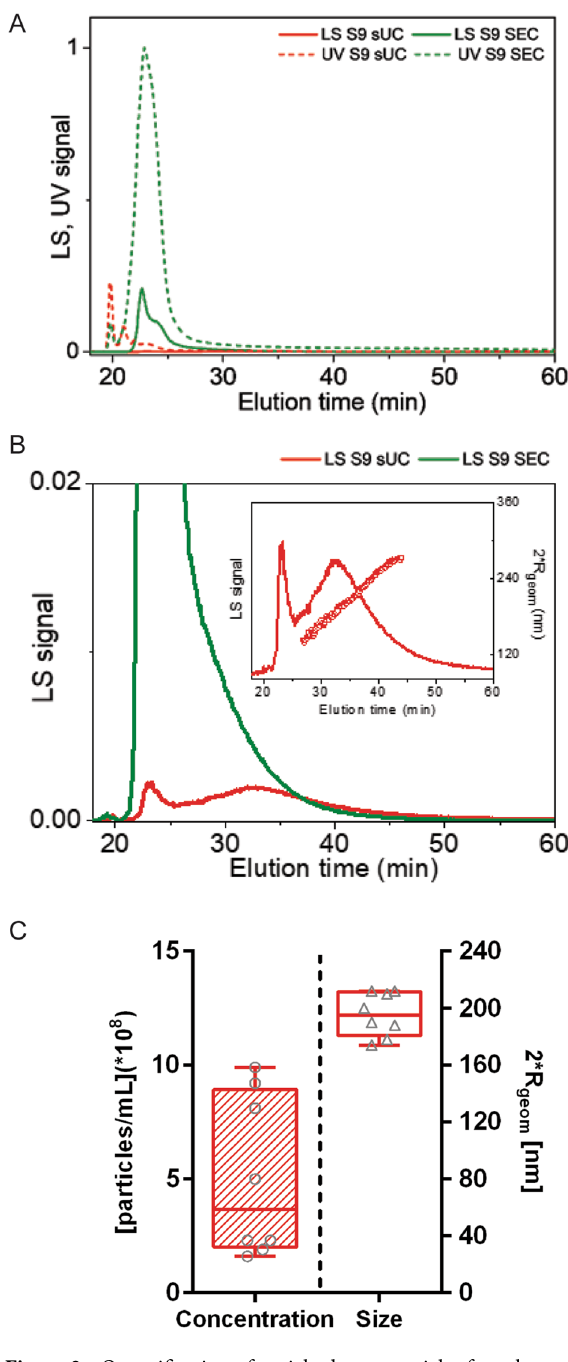
Figure 2. Quantification of enriched nanoparticles from human blood plasma by AF4-UV-MALS. ( A ) Representative fractogram. Representation of MALS (LS) and UV signals in relation to elution time in sample from subject 9 (S9) after sUC or SEC. Dotted lines present UV signals, solid lines present MALS signals. ( B ) Representative fractogram. Magnification of the MALS(LS) signal. The inset represents calculated size of eluted particles, presented as 2* R geom . ( C ) Particle size and concentration in samples after sUC. Each circle or triangle presents one sample. N = 8. AF4-UV-MALS asymmetrical flow field-flow fractionation with ultraviolet and multi-angle light scattering detectors, sUC sucrose cushion ultracentrifugation, SEC size exclusion chromatography, R geom geometric